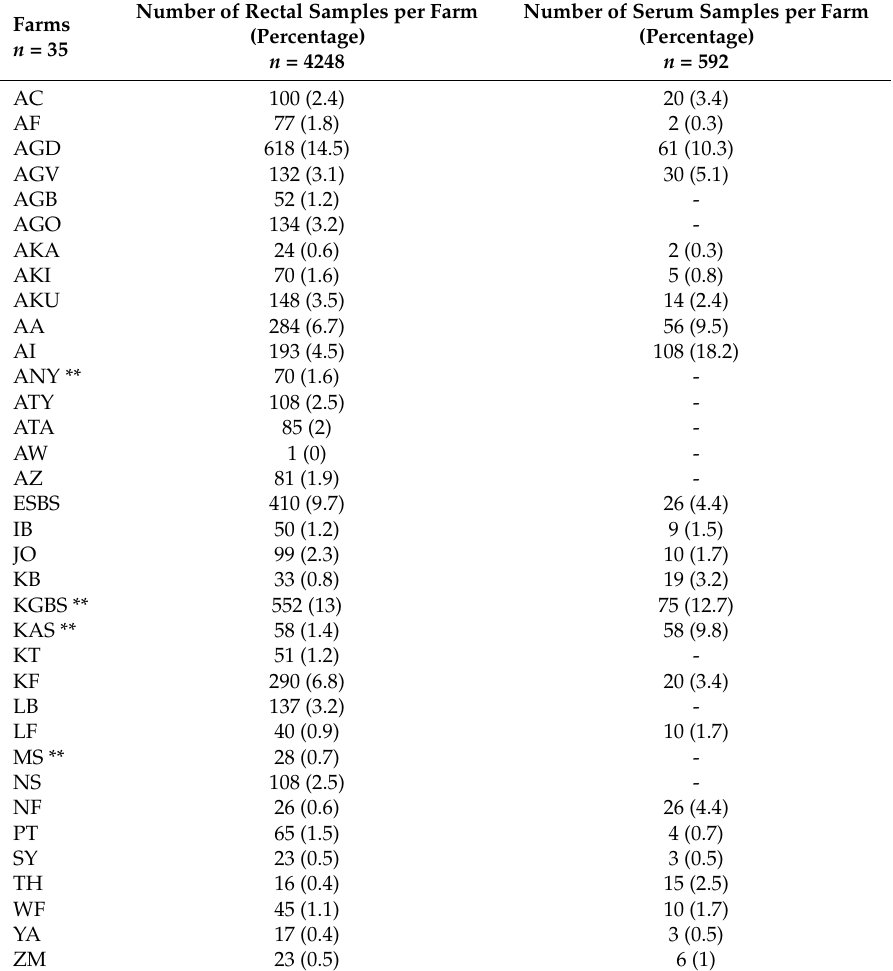
Table 1. Distribution of livestock samples from study